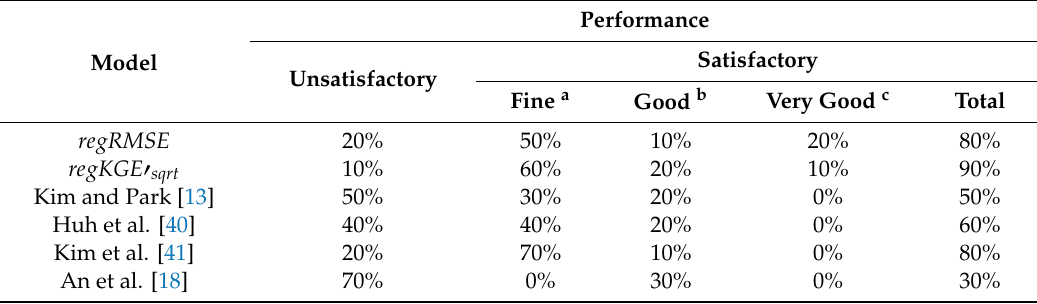
Table 6. Comparison of the performance of the two regional models ( regRMSE and regKGE (cid:48) sqrt ) and others prepared for the 10 validation watersheds.